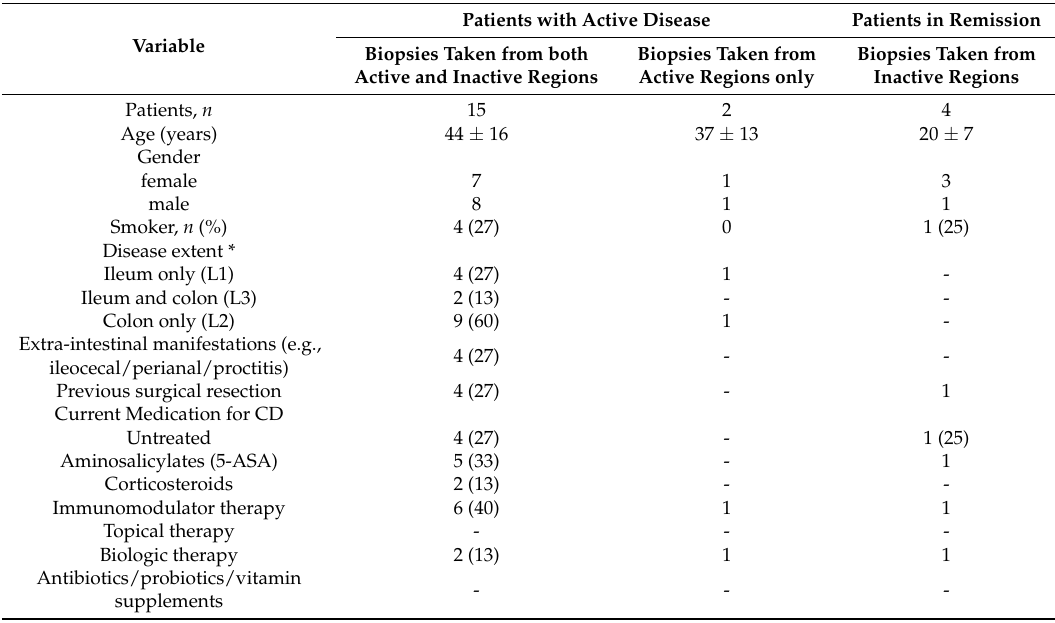
Table 2. Clinical characteristics of Crohn’s disease patients.